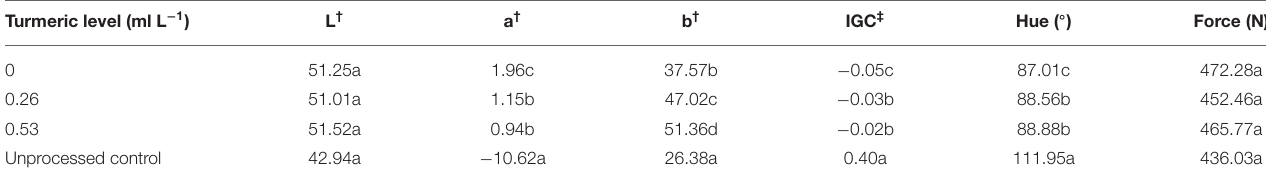
TABLE 2 | Average color and texture for edamame variety “8080” after pasteurization in an acidic brine with different levels of the turmeric effect, and a 6-min boiled control not subject to acidic brine treatment that simulates the standard blanched-frozen-cooked product. Turmeric level (ml L − 1